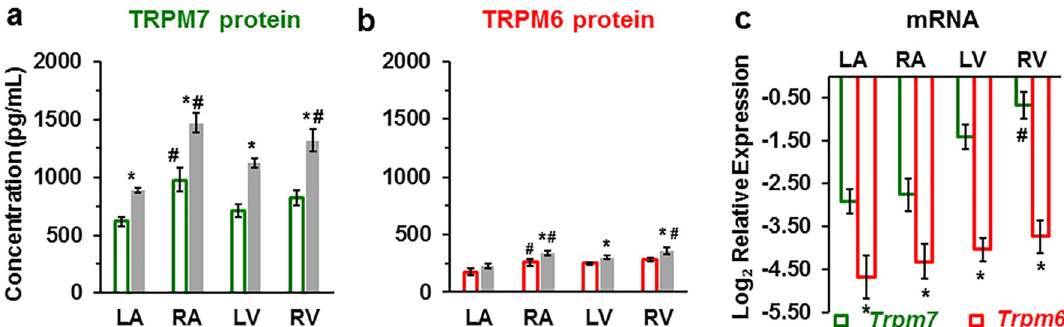
Figure 6. TRPM7 and TRPM6 protein levels and RT-qPCR mRNA relative expression levels in human heart tissue homogenates. ( a, b ) TRPM7 and TRPM6 proteins are increased in the walls of all heart chambers with IHD ( filled columns ) vs. non-IHD ( unfilled columns ). A blinded study-design (with the diagnosis unknown to the investigator) was used for the detection of protein concentration in the various samples. Values (mean ± SEM) are in pg/mL and from 3–33 heart tissue homogenates. * P < 0.05 IHD vs. non-IHD, # P < 0.05 right-sided vs. left-sided using ANOVA with LSD test (Least Significant Difference). ( c ) mRNA relative